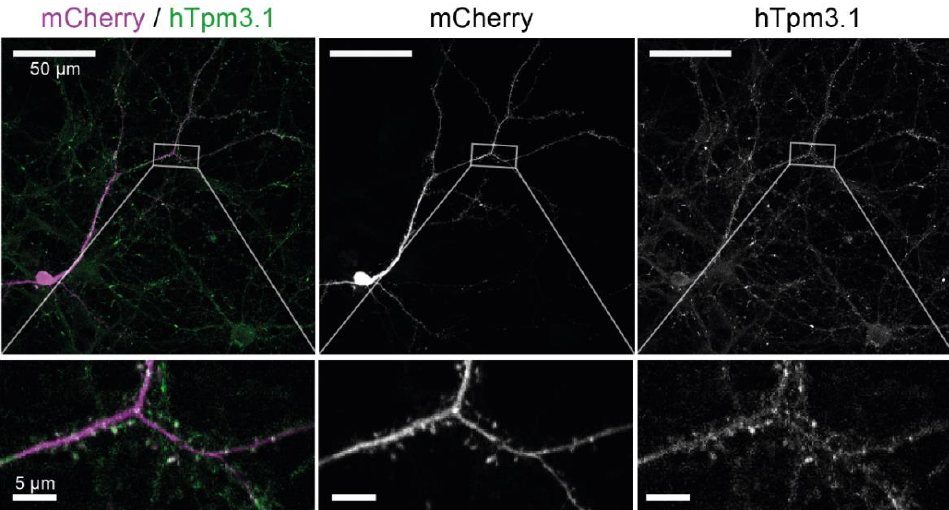
Figure 2. Staining for hTpm3.1 shows that it is enriched in dendritic spines. From left to right: merged image with mCherry in magenta and hTpm3.1 in green, mCherry channel, and hTpm3.1 channel.